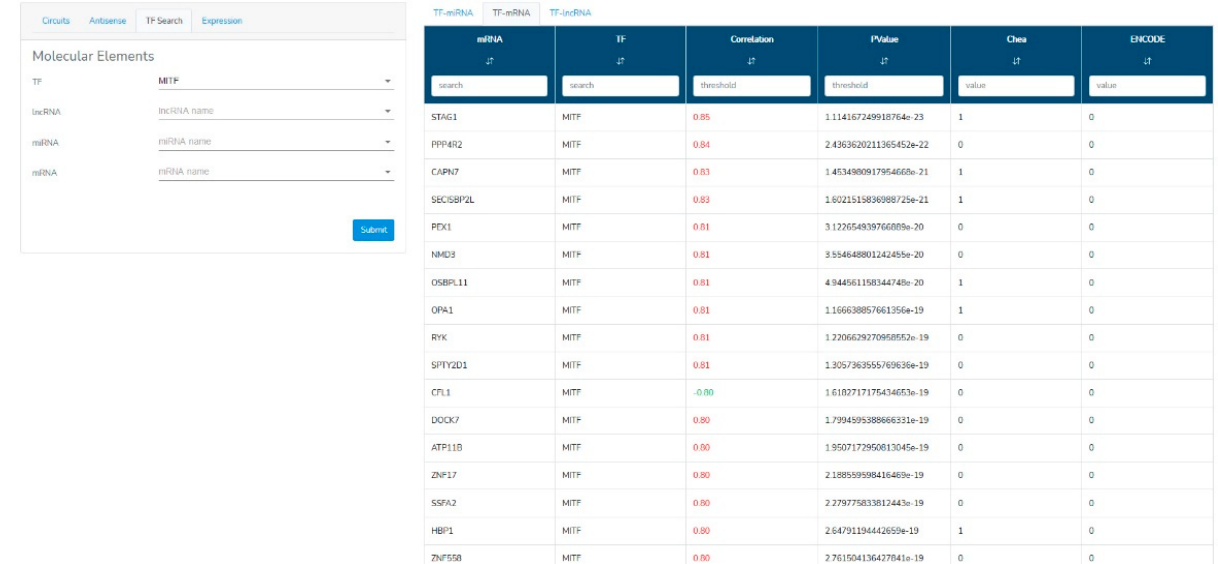
Figure 5. Results section of the VECTOR database for “TF search” query. The table shows expression correlation among the TF and the RNA species, with the associated p-value. The presence of an experimentally validated TF binding site according to Chea and ENCODE is reported as 1 (yes) or 0 (no).